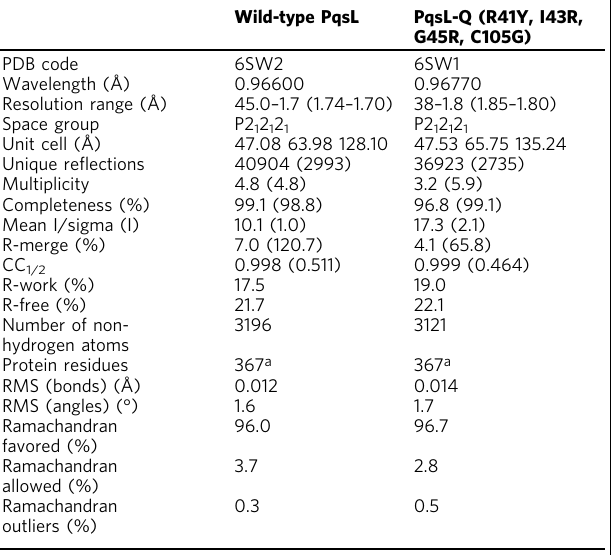
(Fig. 2d). According to previous data, it is unlikely that amine hydroxylation is the rate-limiting step of the reaction 15 .